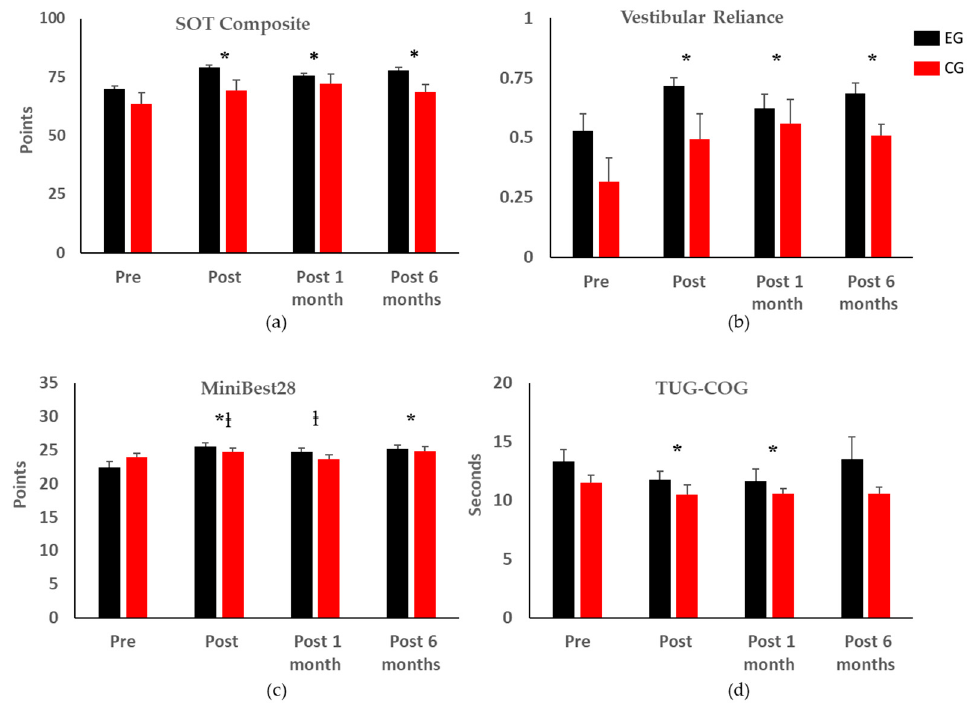
Figure 3. Statistical analysis of clinical balance test outcome metrics (* indicates significant differences with respect to the pre-training assessment regardless of group; † indicates significant differences between the two groups). Error bars represent the standard errors of the means. Only the clinical balance test outcome metrics with significant changes are shown; the complete results can be found in Appendix A. ( a ) SOT Composite: Sensory Organization Test Composite Score; ( b ) Vestibular Reliance calculated from the SOT; ( c ) Mini-BESTest28: Mini Balance Evaluations Systems Test with total score of 28; ( d ) TUG-COG: Timed up and Go with Cognitive Task.